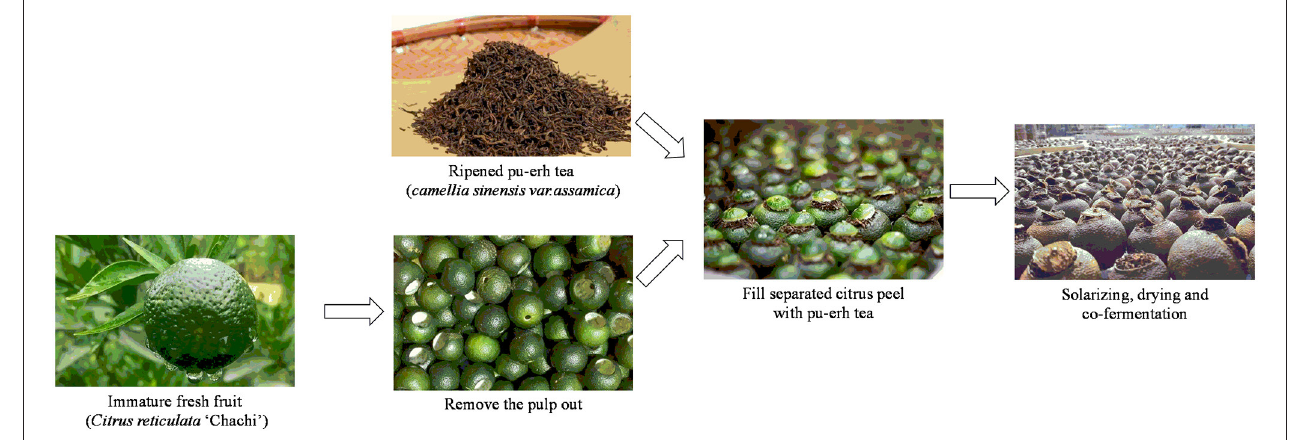
FIGURE 1 | The manufacturing process of Ganpu